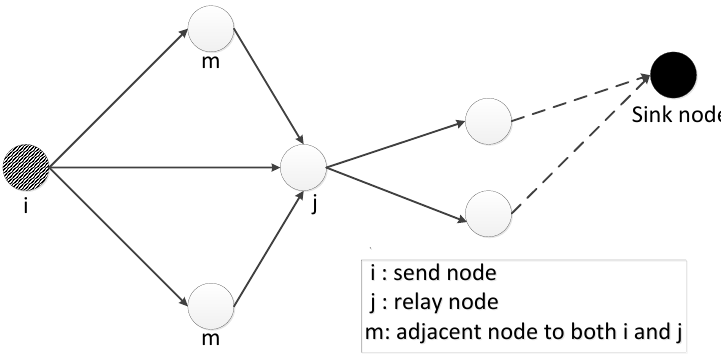
Figure 2. Direct or indirect attack